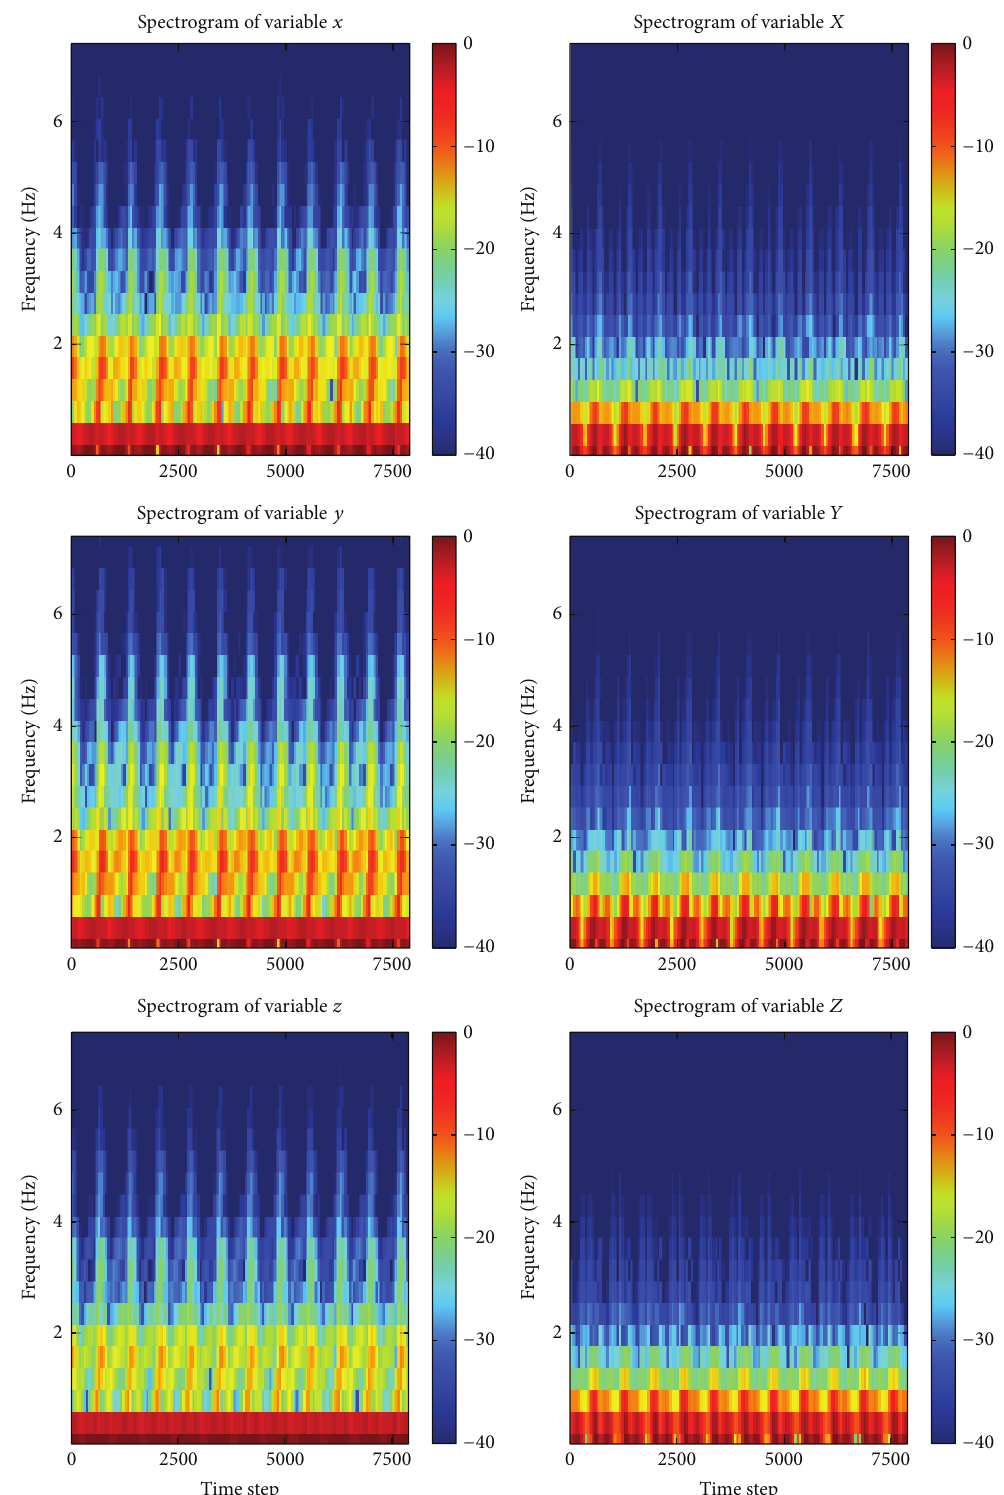
Figure 12: Spectrogram of fast and slow dynamic variables for 𝑐 = 0.8